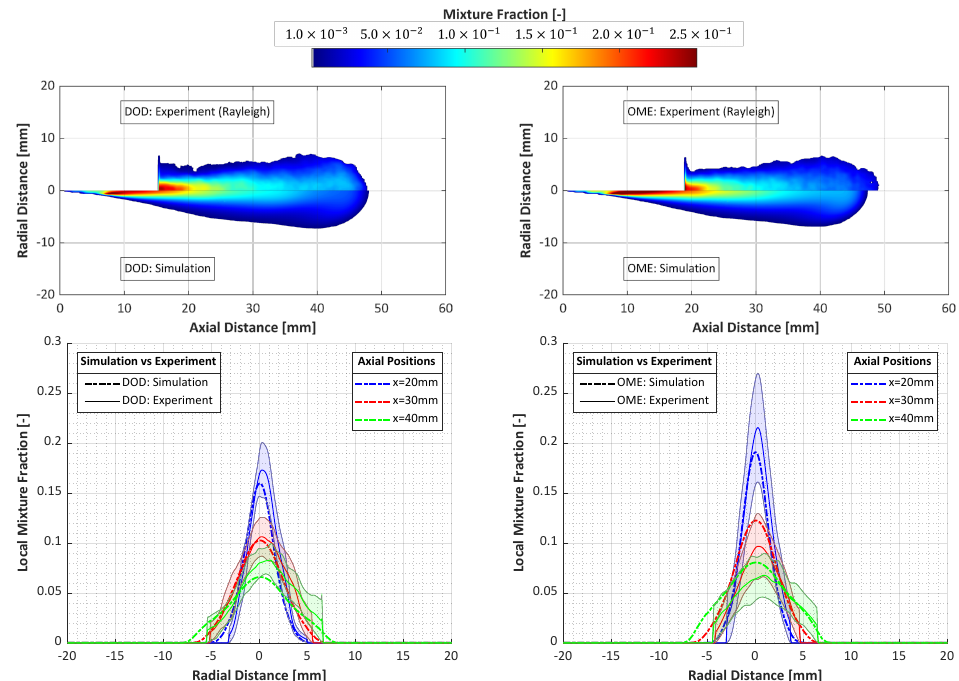
Figure 7. SprayA3 ( Ai ) @ t aSOI = 1000 µ s : Mixture fraction in central spray axis plane: Contour ( top ) and radial profiles ( bottom ): ( left ) Dodecane. ( right ) OME. The centerline mixture fraction is plotted on the left in Figure 8. The dodecane data shows an almost perfect match between simulation and experiment in between 20 < x < 40 mm. For OME the overestimation of the mixture fraction is also visible on the center line, hinting at possible errors in simulating the entrainment of ambient nitrogen into the fuel vapor spray. However, the error remains within the standard deviation of the experiment.